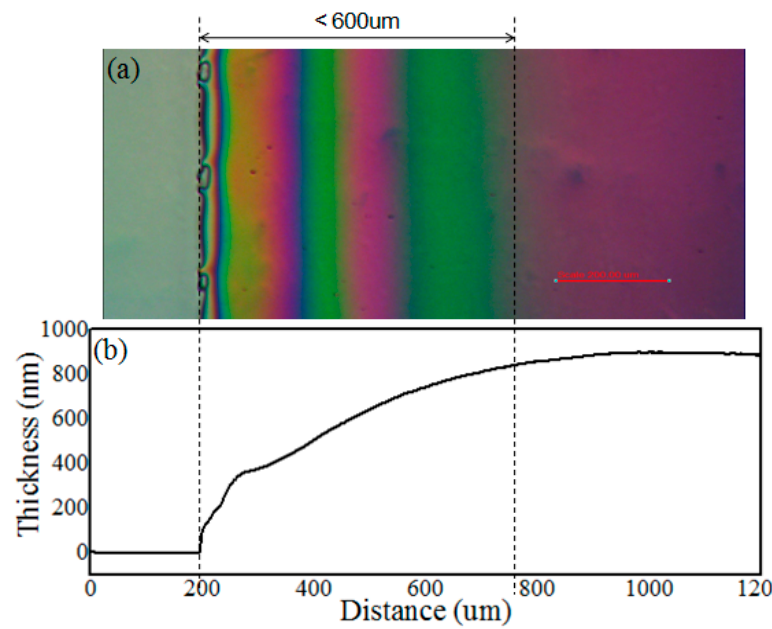
Figure 1. ( a ) Optical micrograph and ( b ) surface morphology data measured by stylus profiler at the edge of the fluoropolymer pad.